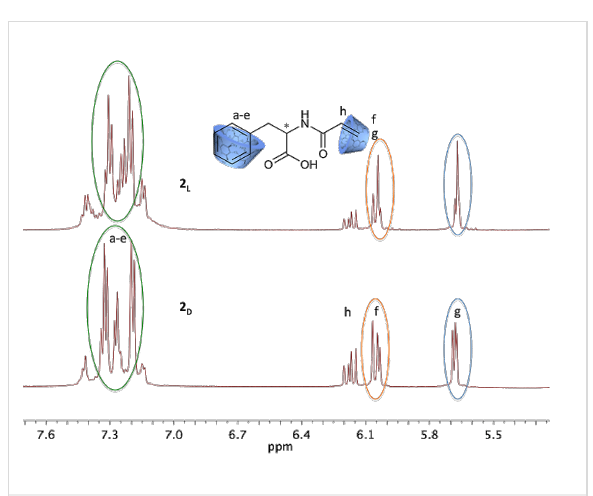
Figure 4: Comparison of 1 H NMR spectra of 2 D and 2 L complexed with β -CD.